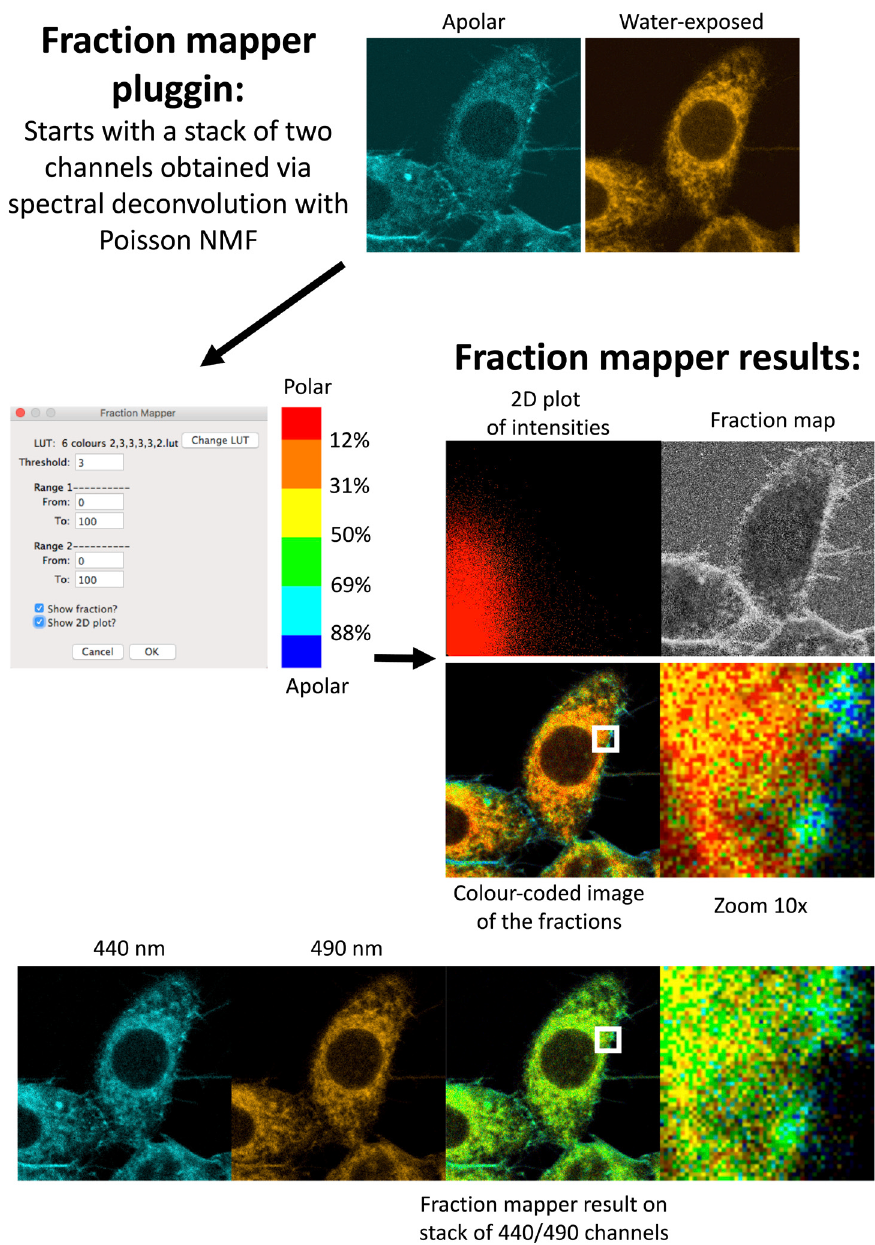
Figure 10. The Fraction Mapper plugin. Starting from a stack of two channels, Fraction Mapper calculates the fraction of the intensity in the first channel for every pixel (ch1/ch1+ch2), which can be obtained as a fraction map. A 2D plot of the intensities in each of the channels can also be generated. The plugin then colour-codes the numbers corresponding to the fraction according to a chosen LUT, and gives the pixels the light intensity of the sum of the two channels. The LUT used was based on six discrete colours from blue to red (LUT ‘6 colours 2,3,3,3,3,2’ available for download as Supplementary File 2). Bottom row: Starting from the 440 nm and 490 nm channels, classically used for calculating GP, the picture obtained is much less informative. Of note, GP values are closely related to fraction values we use in this study: the GP can be obtained simply by multiplying the fraction by two and subtracting 1. Owen et al . have produced and published a ‘GP Calculator’ plugin (Owen et al. , 2011) that provides very similar results to those obtained with Fraction Mapper, albeit by a more indirect approach. The 10× magnifications correspond to the 52×52 pixels regions indicated by white squares in the adjacent image; each pixel is 100×100 nm and the whole pictures cover 52×52 microns.